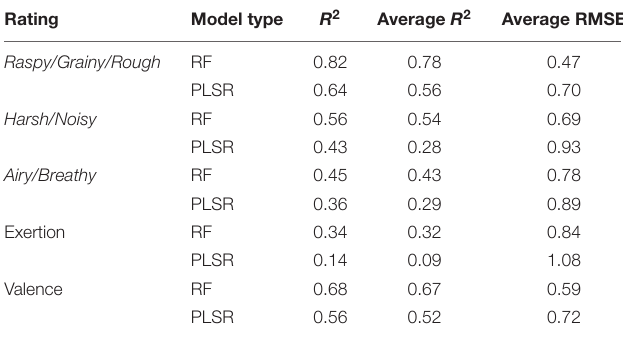
TABLE 4 | Summary of models predicting mean ratings from audio